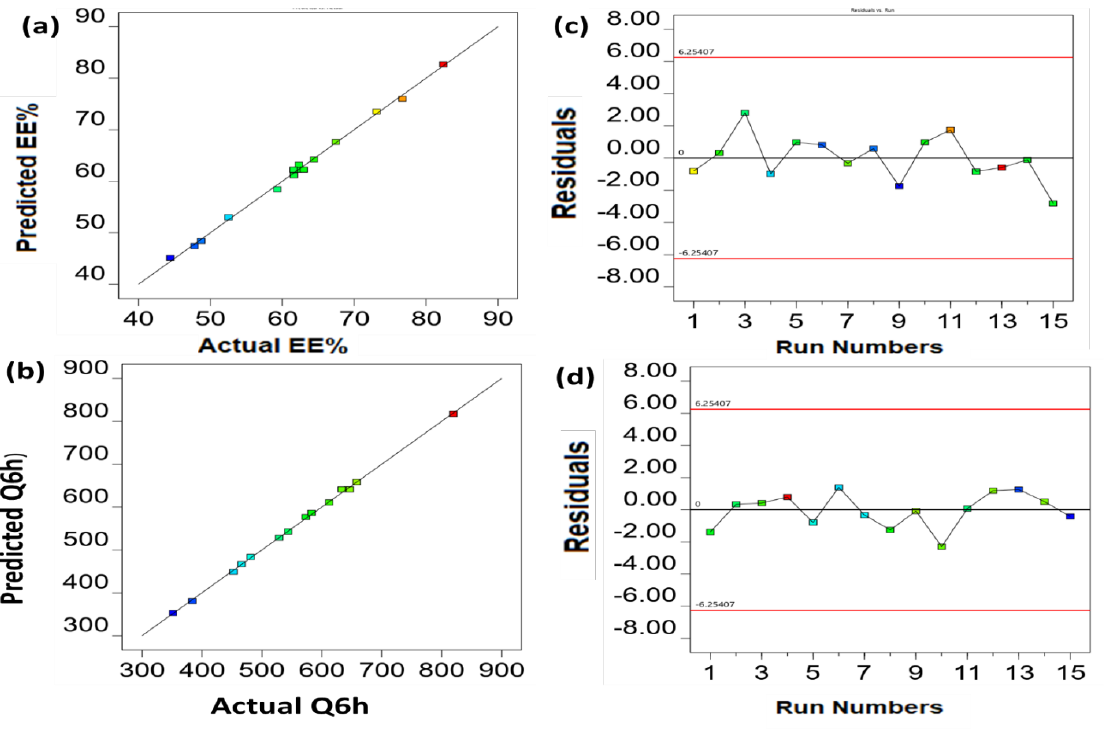
Figure 2. Linear correlation plots ( a , b ) between predicted and actual values and ( c , d ) the corresponding residual plots for different responses.